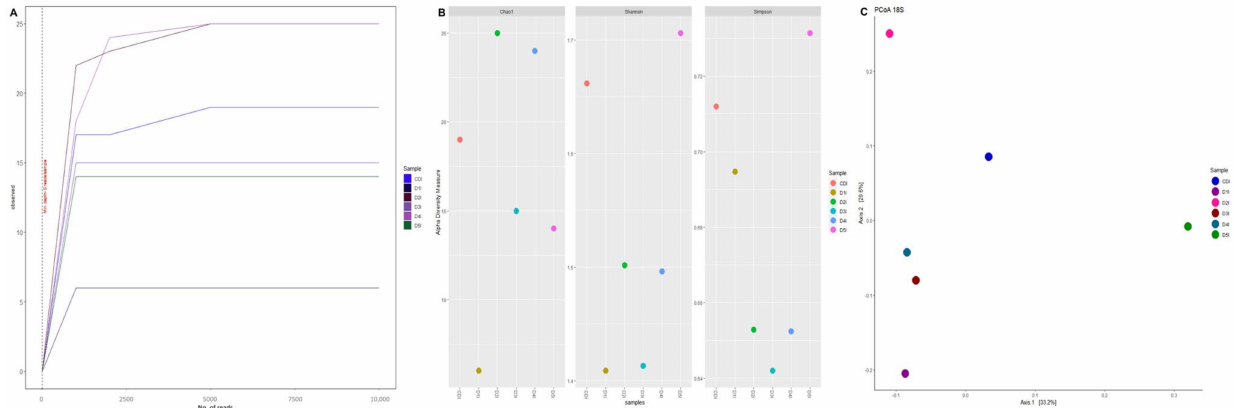
Figure 4. 18S rRNA gene sequencing of intestines from shrimp fed control diet and 50% fishmeal replacement diets. ( A ) Rarefaction curve, ( B ) Alpha diversity, and ( C ) Microbiota structure visualized using principal coordinate analysis (PCoA) plots. Abbreviation: Intestine (I). CD (200 g/Kg FM), D1 (0.13% DL-MET), D2 (0.06% MET-MET), D3 (0.19% MET-MET), D4 (0.13% DL-MET plus 0.10% B. amyloliquefaciens CECT 5940) and D5 (0.06% MET-MET plus 0.10% B. amyloliquefaciens CECT